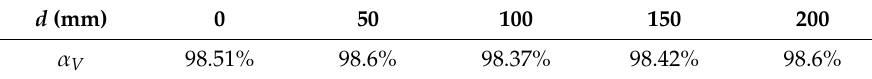
Table 2. Comparison of the vertical stability of the external receiver coil.